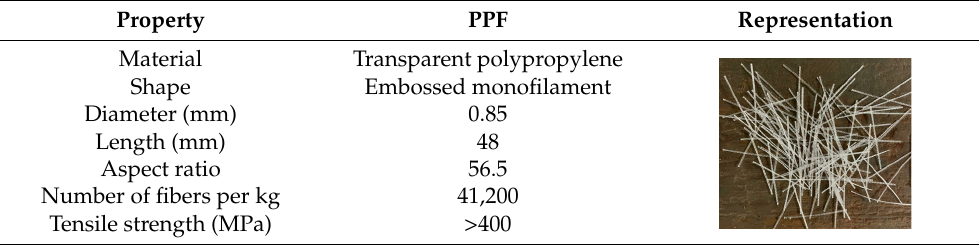
Table 2. Properties of the implemented fiber.